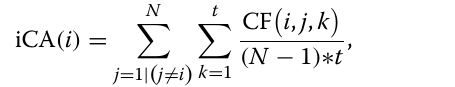
This index measures the probability that two distinct individuals, chosen at random without replacement from the set of N individuals, choose the same solution. It takes the value 1 if all individuals selected the same single solution and 0 if everyone selected a different solution. If solutions are chosen at random, the expected value of the 1 index is n